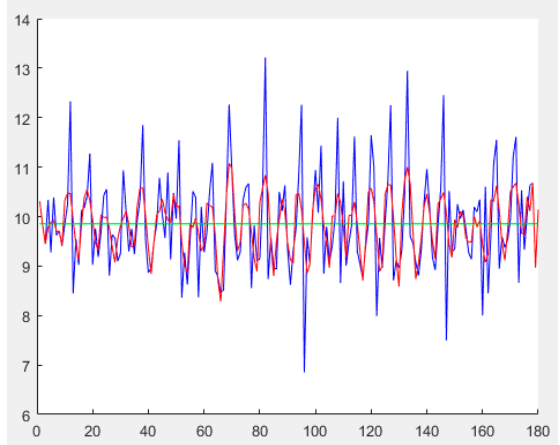
Figure 2. Signals before and after smoothing using the SG filter and the threshold (blue: raw data, red: after smoothing, green: threshold).